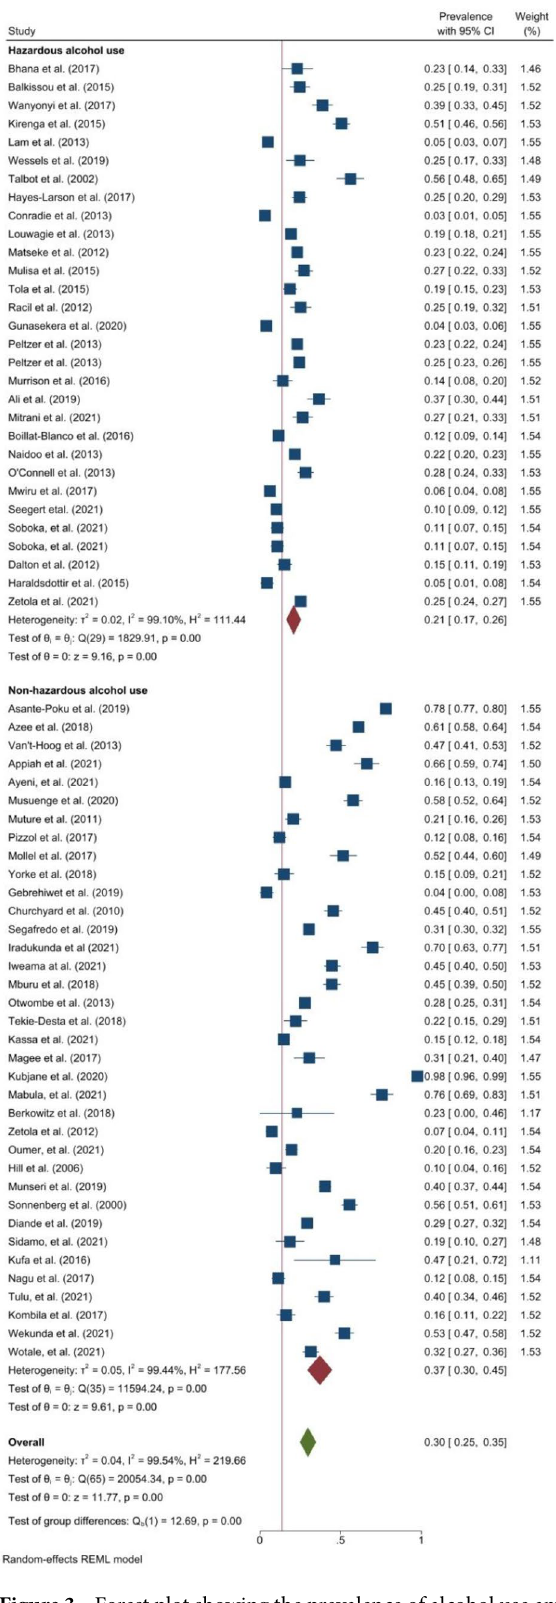
Figure 3. Forest plot showing the prevalence of alcohol use among people with active TB in